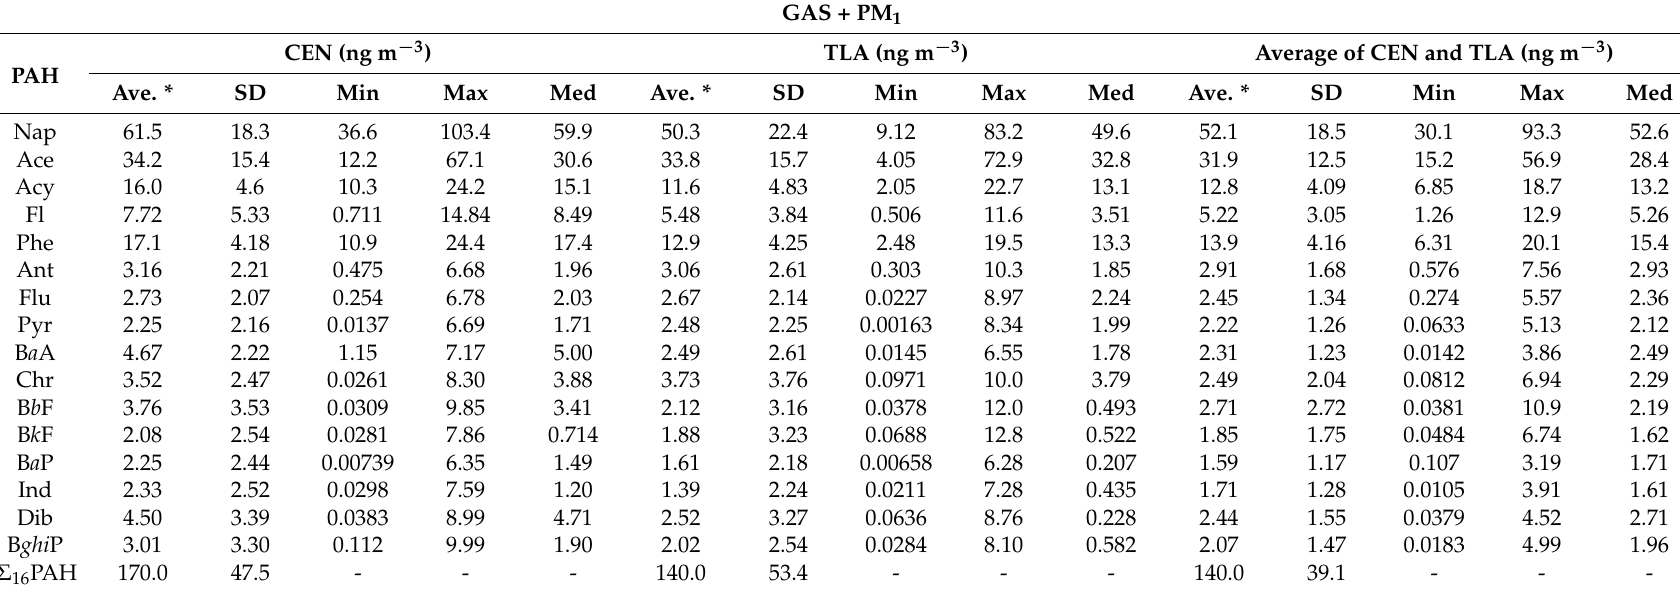
Table 3. Total ambient levels of PAHs in the gas and PM 1 phases determined in the